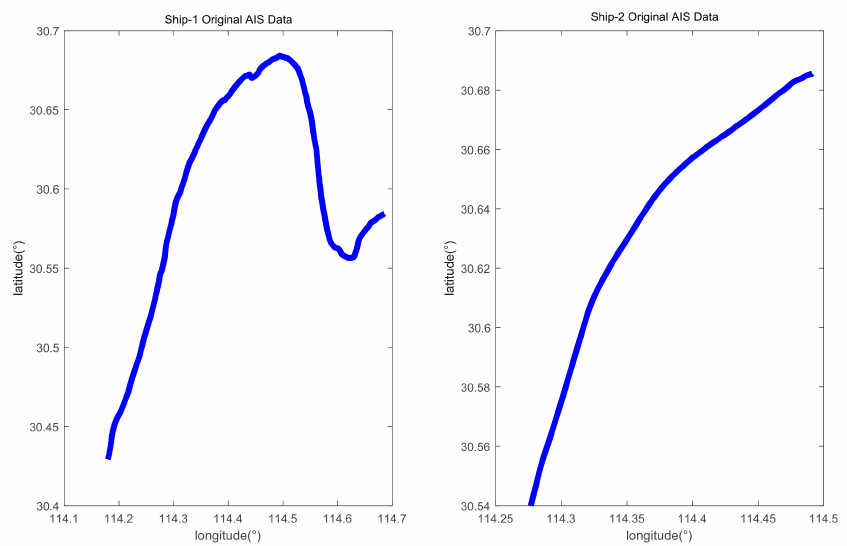
Figure 6. The original trajectories of experimental ships.